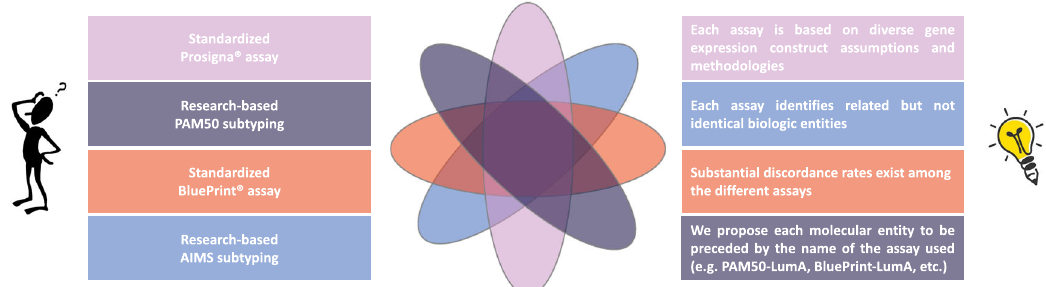
Fig. 2 Main intrinsic/molecular subtypes classi fi ers and tips to avoid scienti fi c and clinical confusion. Main intrinsic/molecular subtypes classi fi ers are resumed in the left boxes. In the right boxes, speci fi c recommendations and a proposal for a new nomenclature of intrinsic/ molecular subtypes are included, in order to avoid scienti fi c and clinical confusion due to the lack of interchangeability between the assays. Diverse assays identify related but not identical biologic entities, which can result in different classi fi cations of the intrinsic subtype for the individual patient, depending on the assay that is being